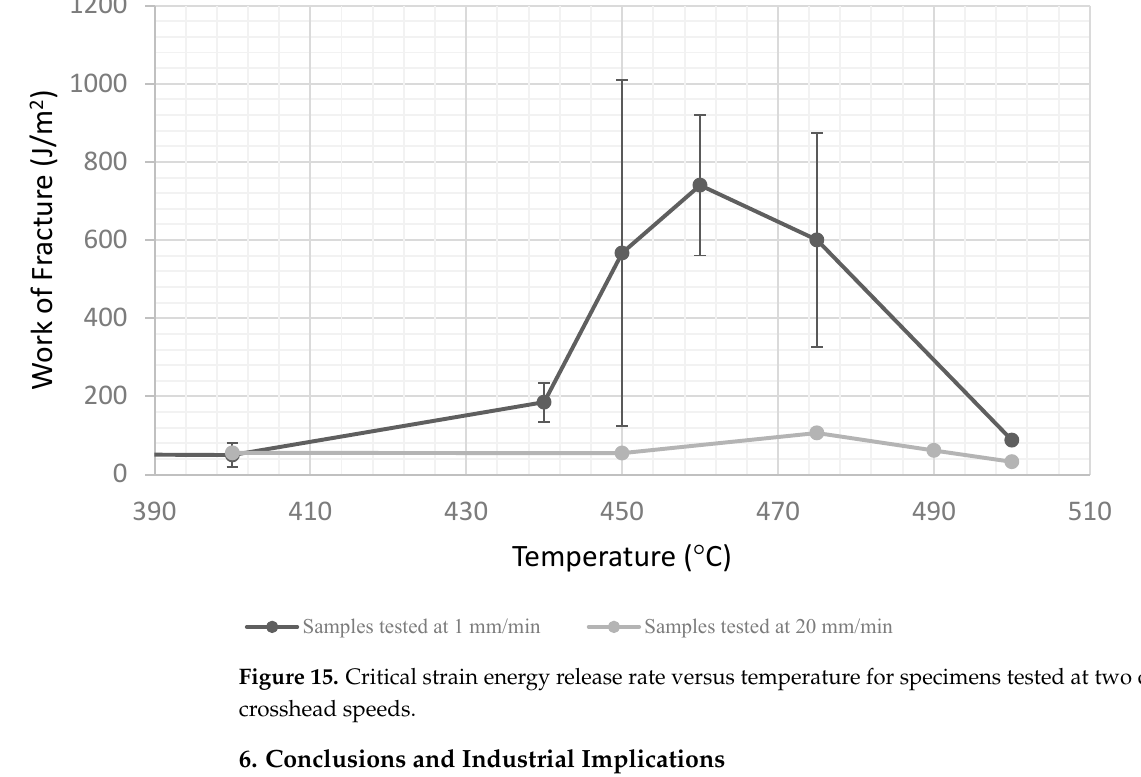
Figure 14. Work of fracture versus testing temperature.